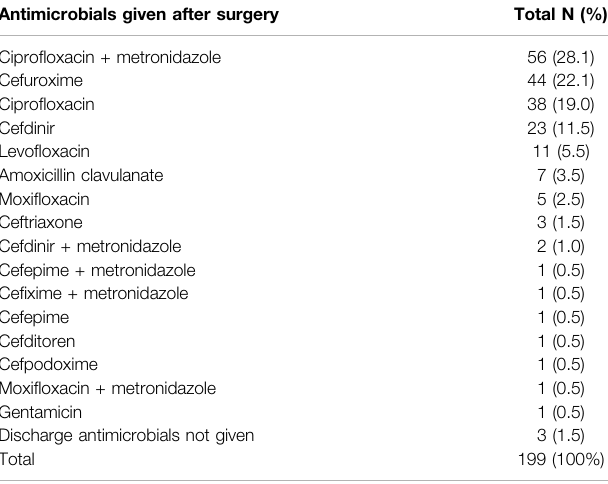
TABLE 7 | Antimicrobials prescribed at post-surgical hospital discharge. Antimicrobials given after